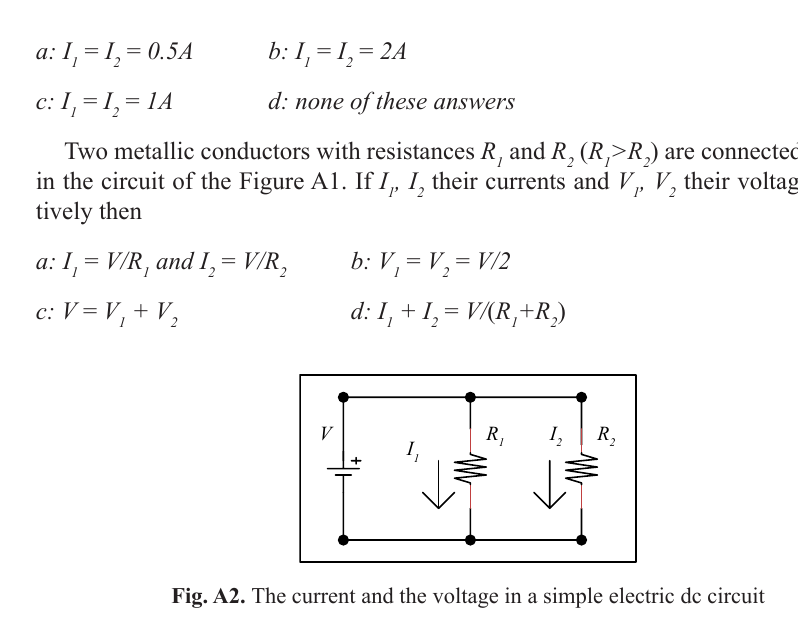
Fig. A1. The current and the voltage in a simple electric dc circuit